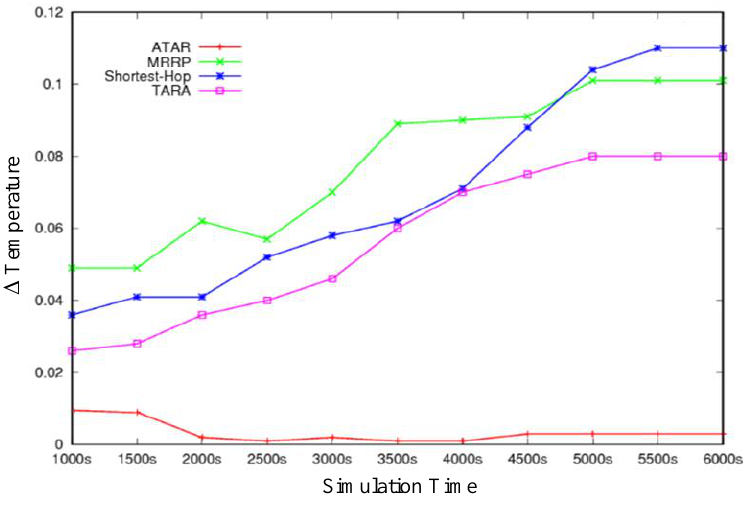
Figure 15. Temperature variation versus simulation